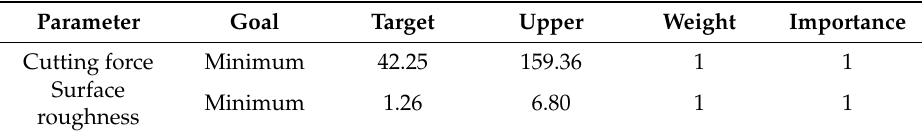
Table 11. The response optimization.